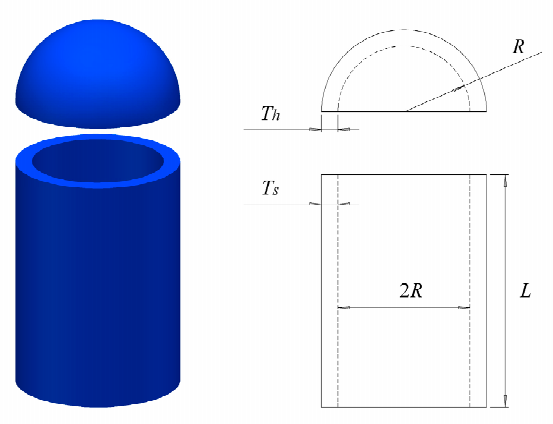
Figure 9. Schematic diagram of pressure vessel design.